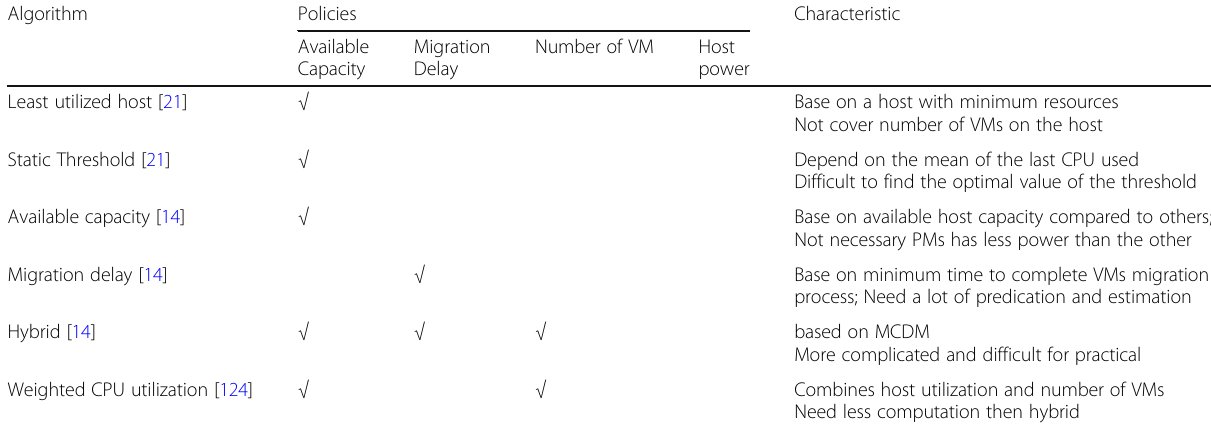
Table 2 Host underload detection algorithms Algorithm